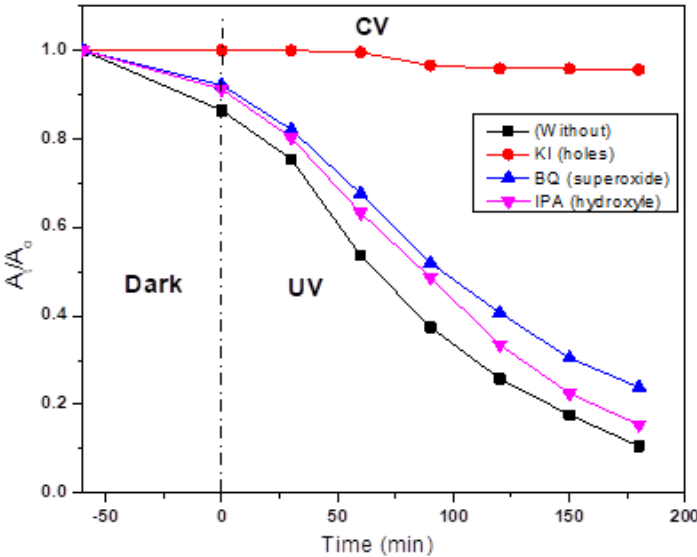
Figure 13. Scavengers affect CV photodegradation using MgO NPs under UV irradiation.